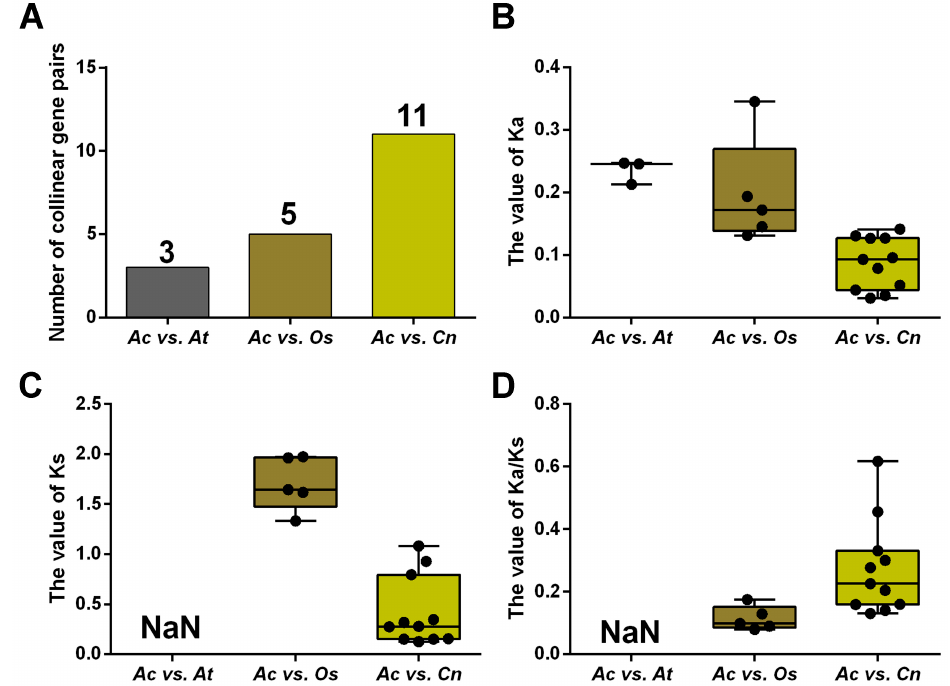
Figure 3. Comparison of NRAMP homologous genes substitution rate. ( A ) The number distribution of the collinear gene pairs in three species. Ac: A. catechu ; At: A. thaliana ; Os: O. sativa ; Cn: C. nucifera .